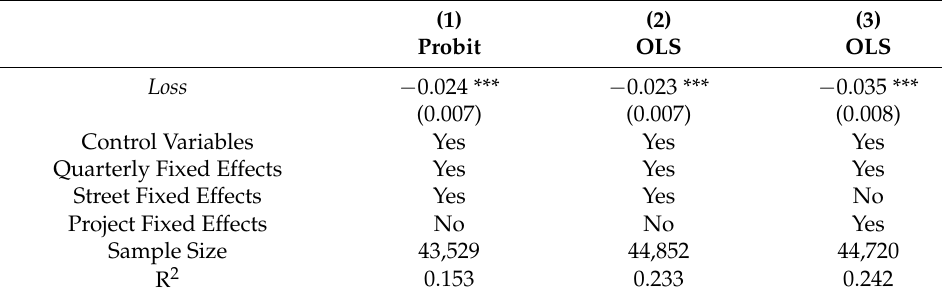
Table 8. Robustness analysis: adjust expected